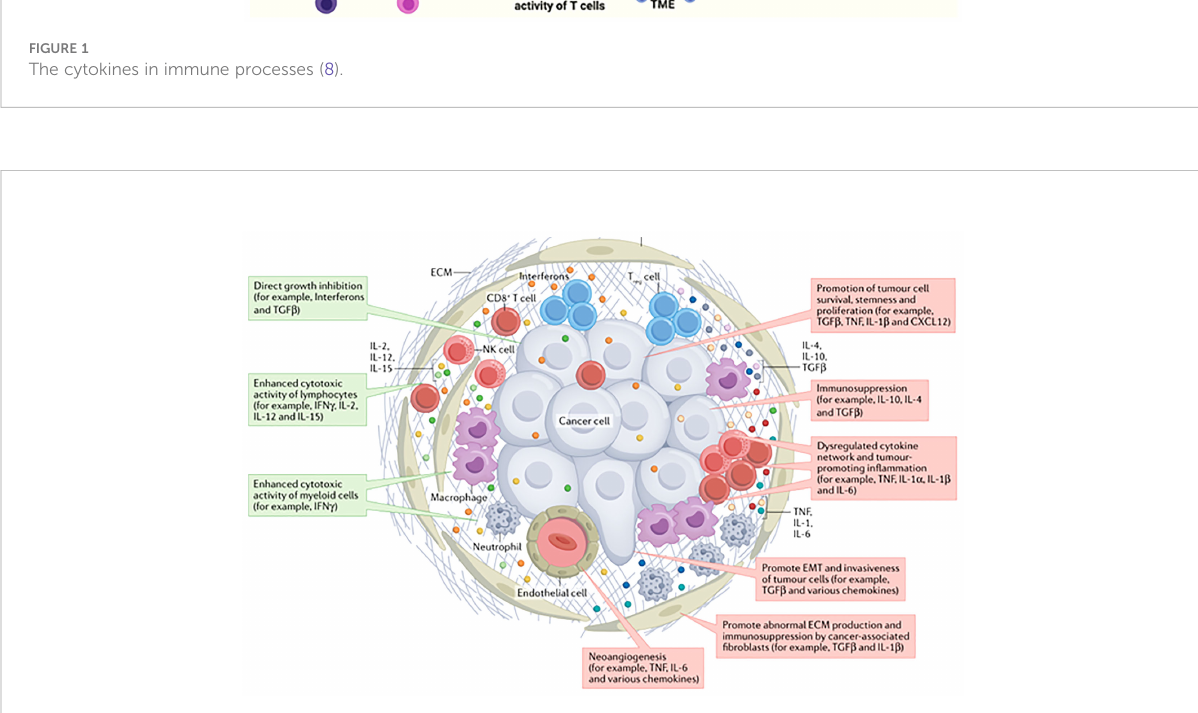
FIGURE 2 The cytokines in tumor environment (10).